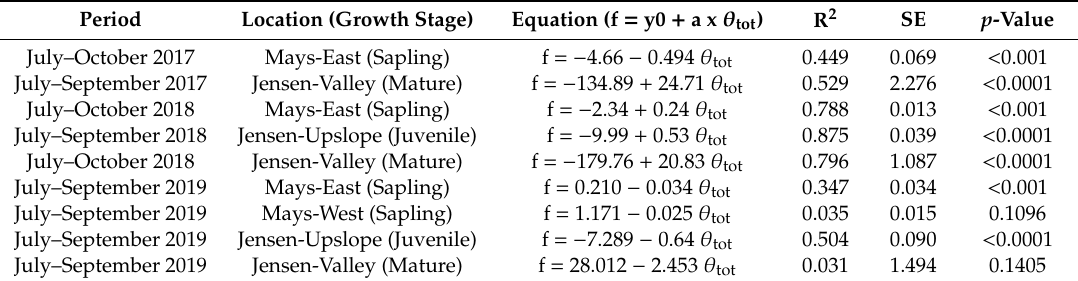
Table 7. Fitted linear equations obtained to determine relationships between daily transpiration rates (y) and top 0.8 m soil average soil moisture content ( θ tot ) for years 2017–2019.